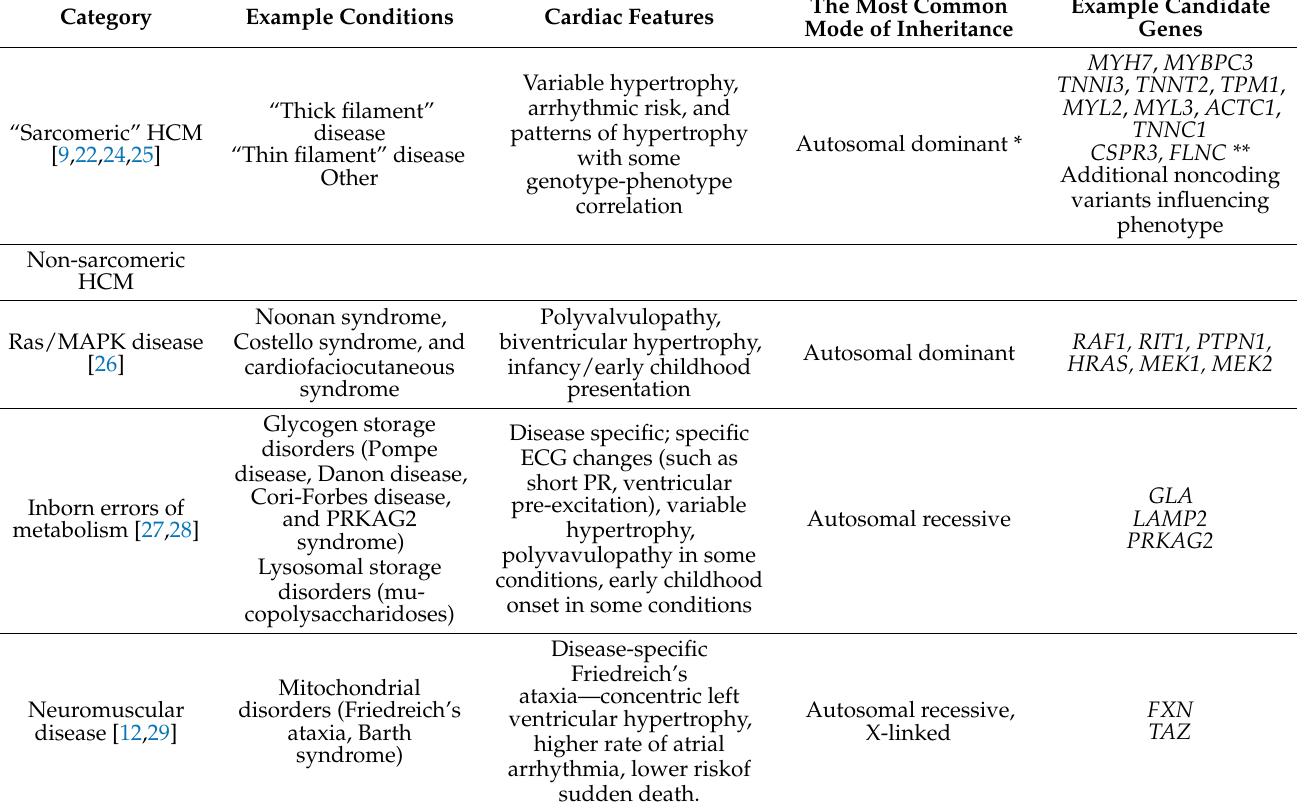
Table 1. An approach to classifying paediatric hypertrophic